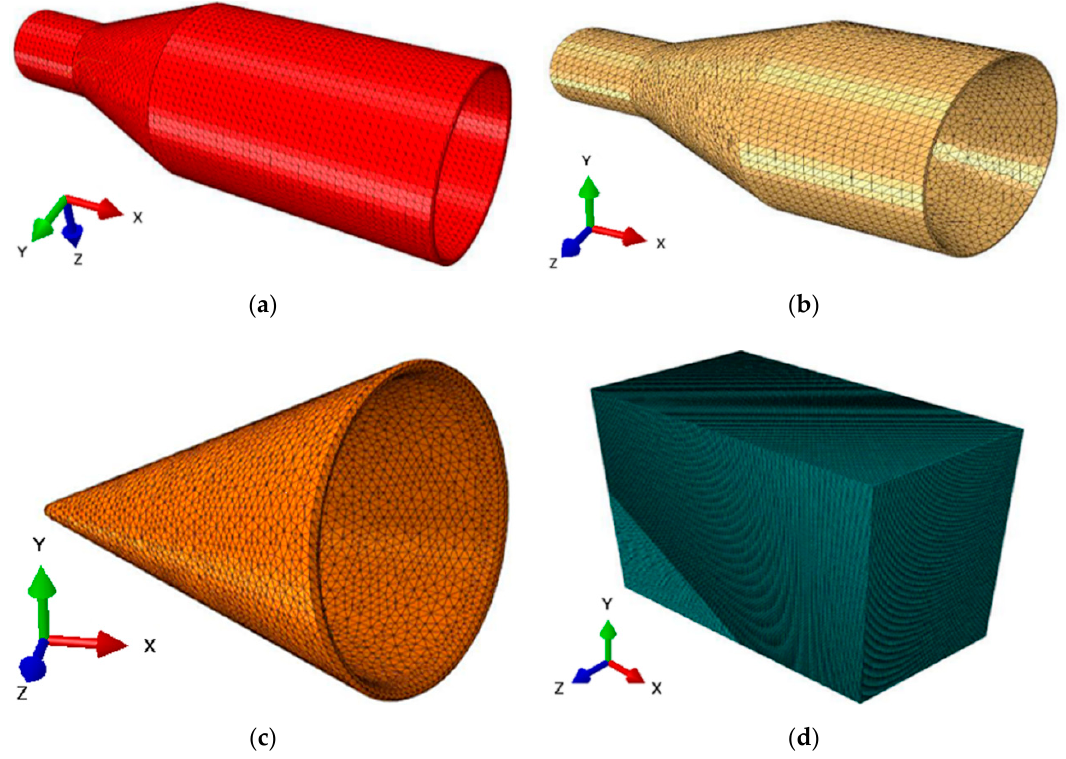
Figure 9. Numerical models of the ŁK charge components: ( a ) plastic case; ( b ) explosive; ( c ) cumulative liner; ( d ) armor